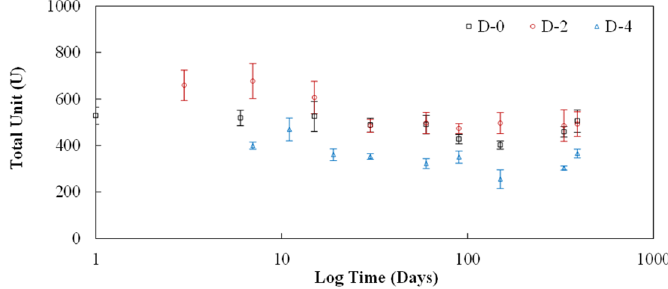
Figure 7. Urease activity measurement in total units for 0%, 2%, and 4% of dextran (D-0, D-2, and D-4) added during lyophilization of crude extract and rehydration and storage at different times at RT.